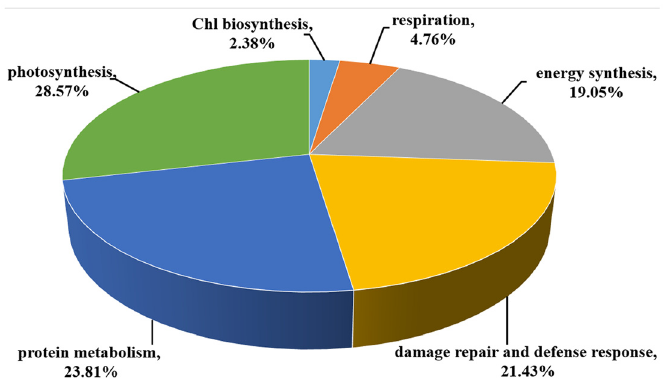
Fig 4. Functional classification of differentially accumulated proteins identified in B . napus leaves under salt